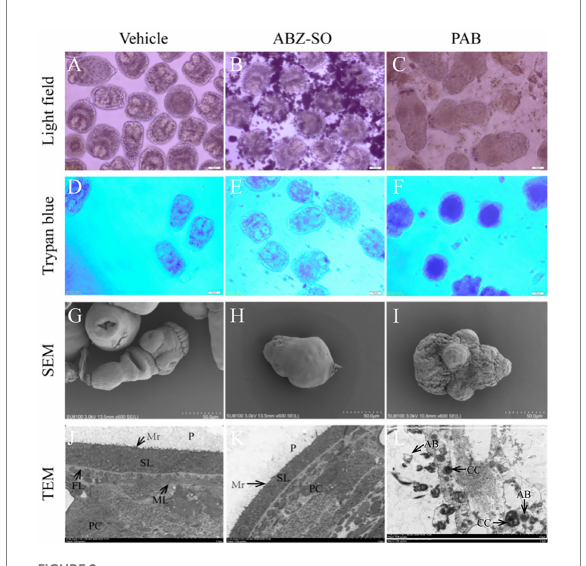
FIGURE 2 Structural morphology changes of E. multilocularis PSC after treatment with PAB in vitro . The PSC treated with PAB (20 μ g/ml) and ABZ-SO (20 μ g/ml) for 2 days were observed using trypan blue staining (D–L) or unstained (A–C) under light microscope (A–F) , 200 × magnification, SEM (G–I) , scale-bars: 50 μ m and TEM (J–L) , scale-bars: 5 μ m. Abbreviations: P, periodic acid-schiff stain positive material; Mv, microvillus; SL, syncytial layer, FL, fibrous layer, ML, muscular layer, AB, apoptotic bodies, CC, condensed